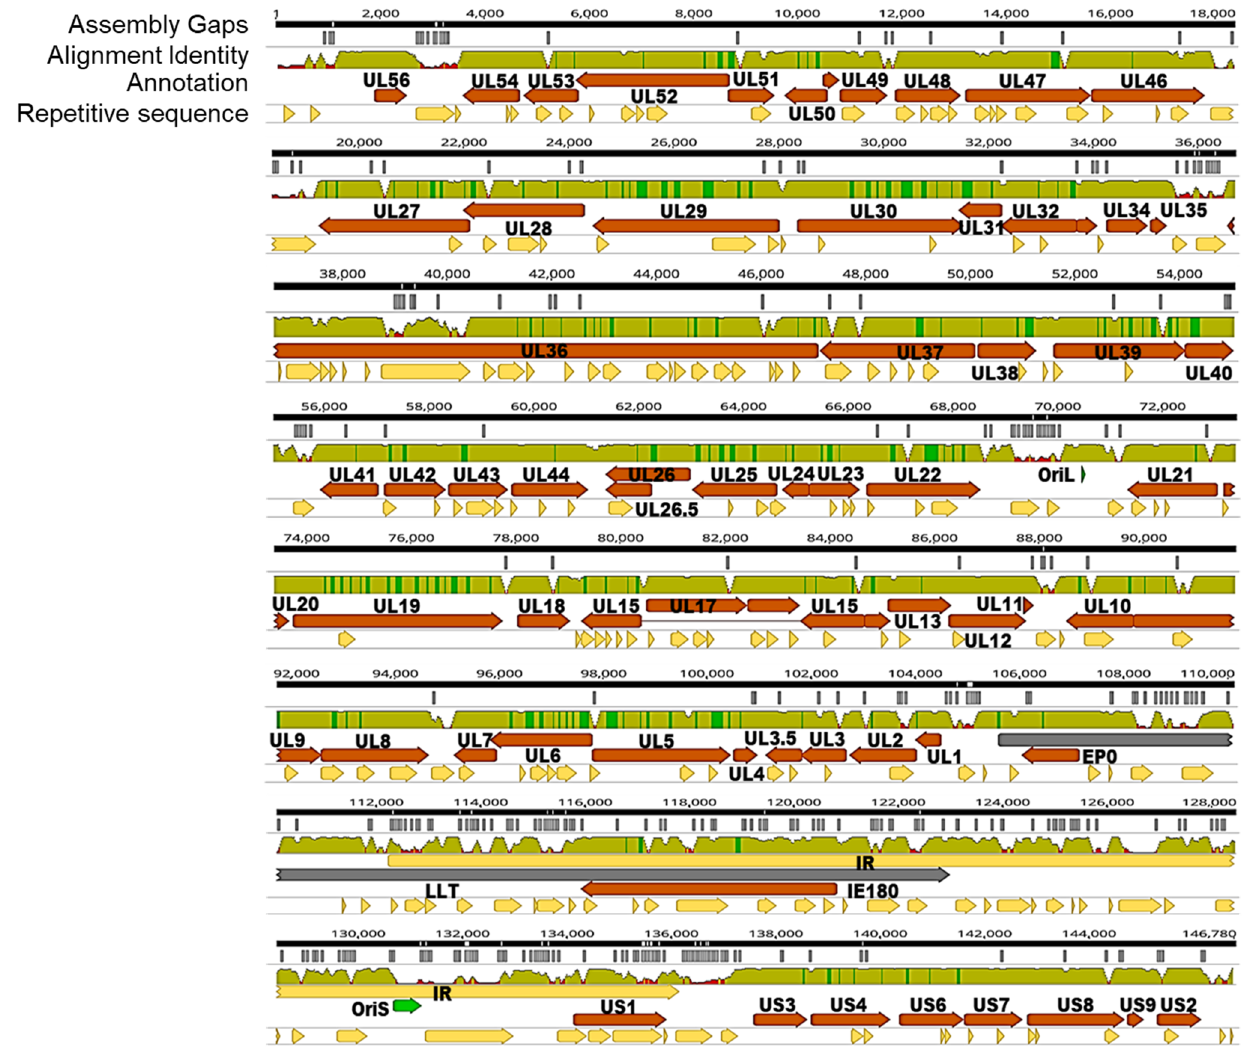
Figure 1. Overview of the sequence diversity in the alignment of 73 PRV genomic sequences. The alignment of 73 PRV genomic sequences was visualized by Geneious Prime. The black bar at the top represents a consensus sequence drawn from the alignment of 73 PRV genomic sequences. The white lines in the second row indicate the distribution of assembly gaps. In the third row, the curve of identity level is plotted from this alignment, which is colored as follows: green, 100% identity; green-brown, 30 to <100% identity; red, <30% identity. The fourth row is the annotation of the PRV genome. The bottom row shows the region of the repetitive sequence of the PRV